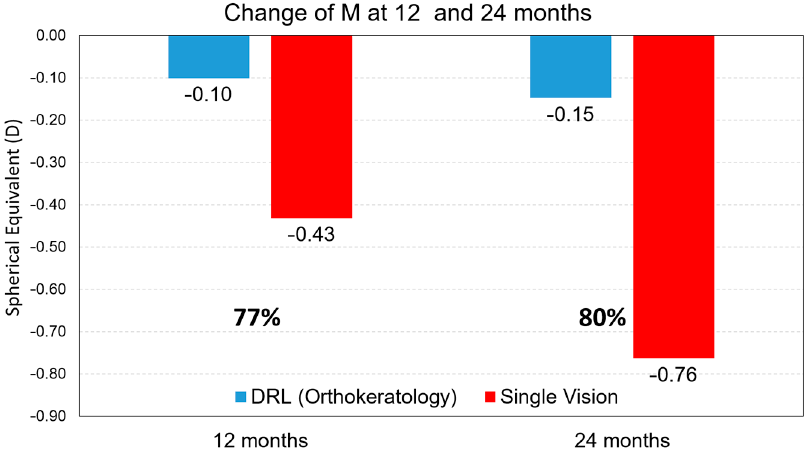
Figure 1. Myopia progression retention rate values, for the M component, after 12 months and after 24 months of treatment between treatments.